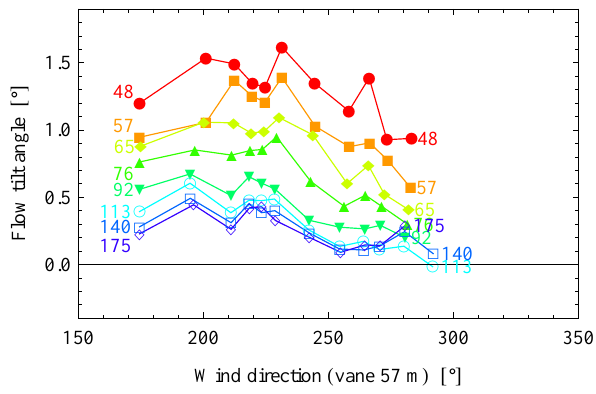
Fig. 6. Mean flow tilt angles measured by lidar at Sorø, all mea- surement